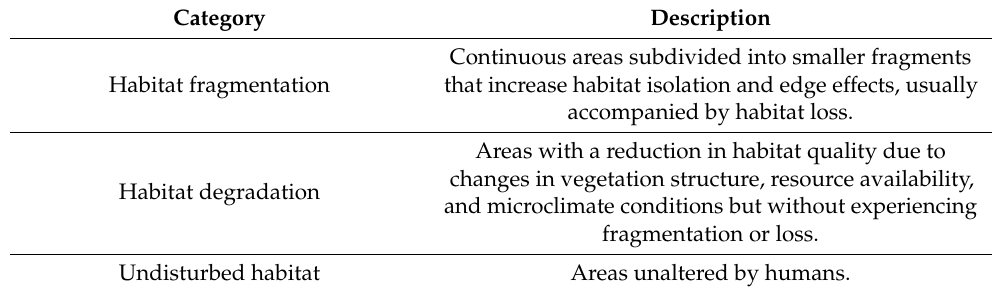
Table 1. Habitat condition